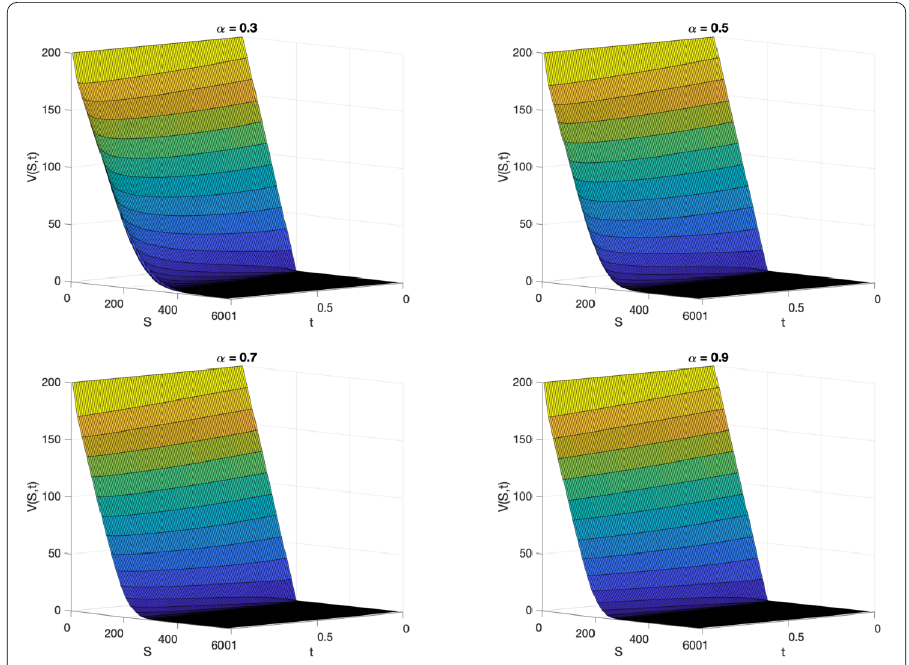
Figure 10 Payoffs under Example 5.2 for α = 0.3,0.5,0.7,0.9; δ = 0.085 for all 0 ≤ t ≤